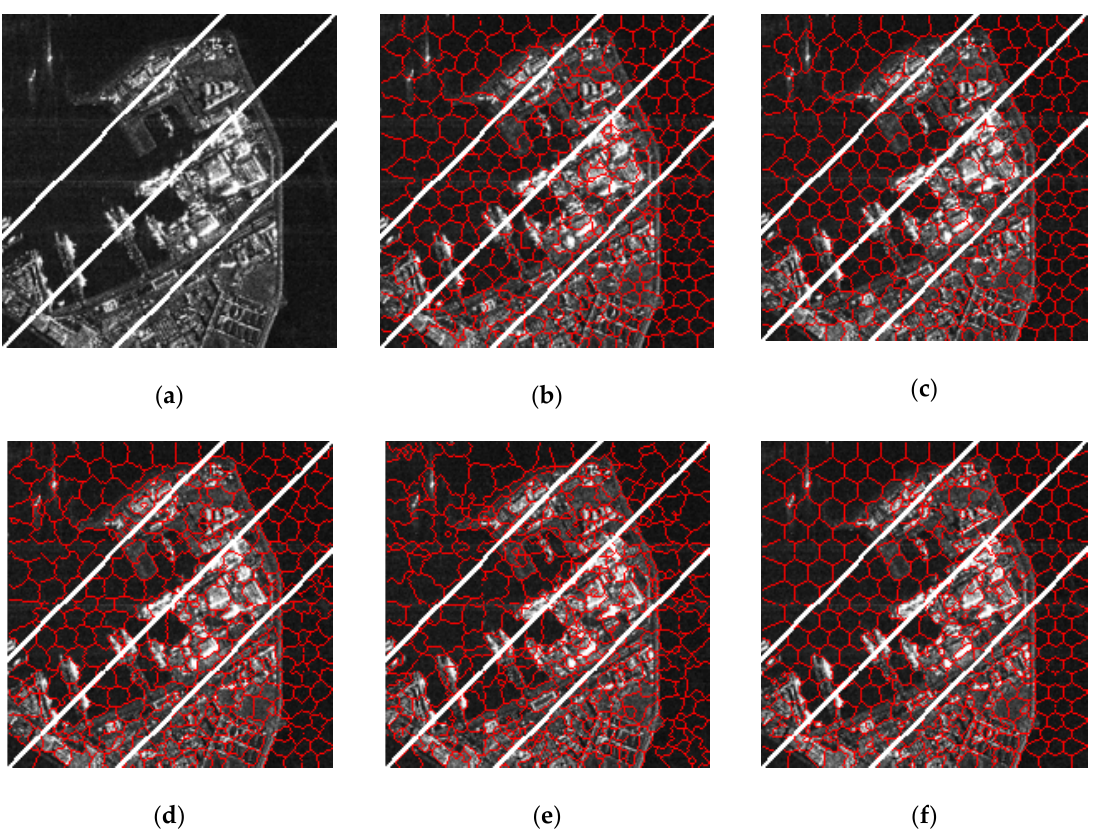
Figure 18. Resulting superpixels of Ferry Port with m set to six and K set to 200, 300, 350, and 500 for regions A, B, C, and D. ( a ) Original SAR image; ( b ) SLIC; ( c ) PILS; ( d ) LBSLIC; ( e ) PBSLIC; and ( f ) PSDSD.